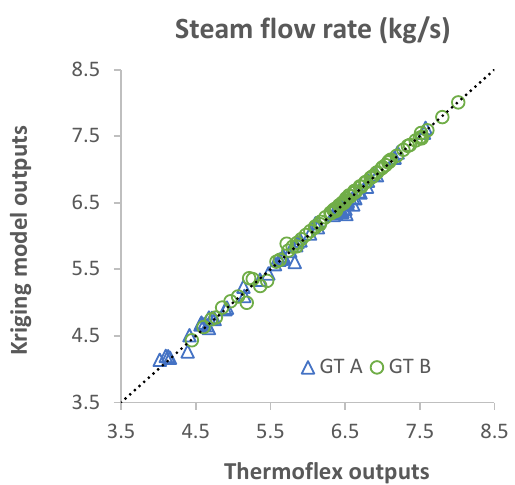
Figure A6. Parity plot of the steam turbine power output for the off-design model validation.